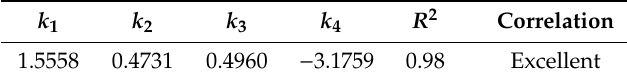
Table 4. Regression parameters of the new model.